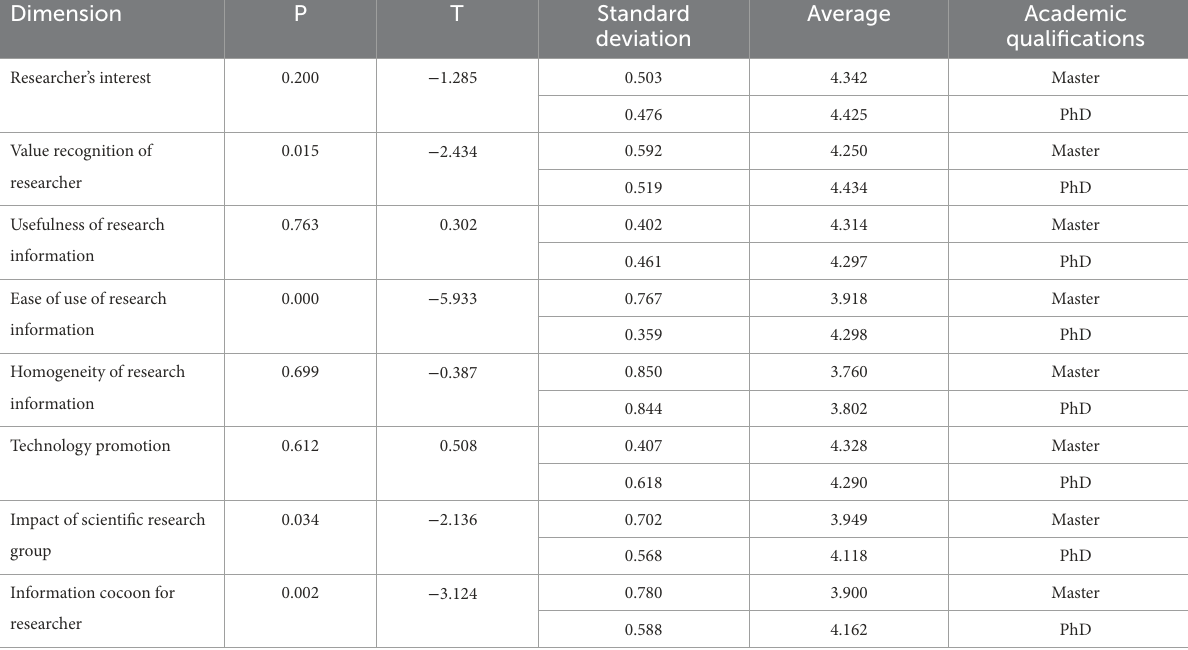
TABLE 4 Differences in dimensions among researchers with different degrees. Dimension P T